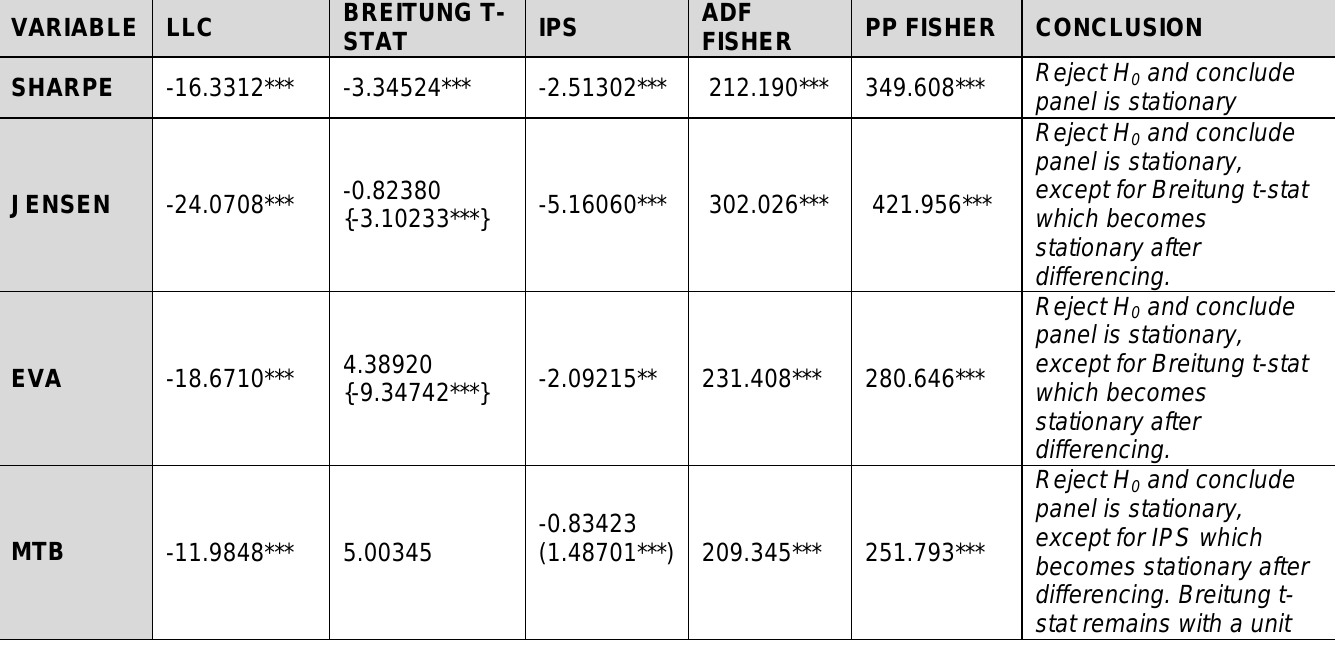
Table 1: Stationarity results